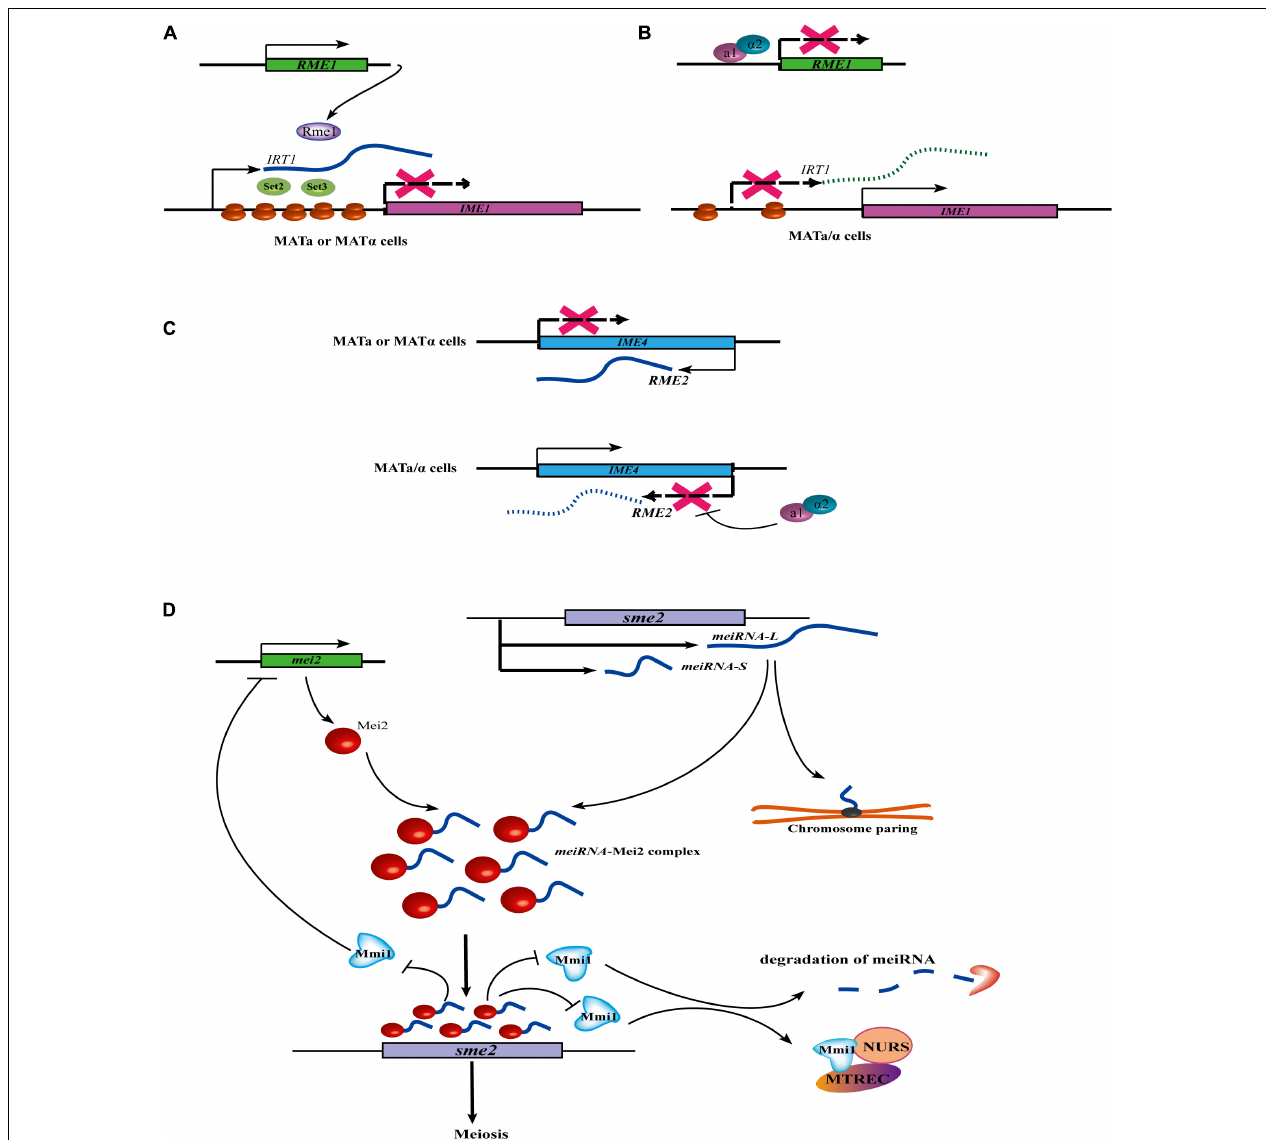
FIGURE 1 | Cell cycle or meiosis control of lncRNA in fungi. (A) In MAT a or MAT α haploid cells, the expression of IRT1 is induced by a transcription activator Rme1. Then transcribed IRT1 can recruit the histone methyltransferase Set2 and the histone deacetylase Set3 at the IME1 promoter, finally leading to the inhibit of IME1 expression. (B) In the homozygous MAT a/ α diploid cells, the a1/ α 2 heterodimer can inhibit the expression of REM1 , so IRT1 can’t be expressed without the induction of Rme1. IME1 can successfully transcript without the repression of IRT1 . (C) In MATa or MAT α haploid cells, lncRNA REM2 inhibits transcription elongation of IME4 to prevent germ cell differentiation. However, in MATa/ α diploid cells, the a1/ α 2 heterodimer represses the transcription of REM2 by binding at a conserved site located downstream of the IME4 , thus allowing for induction of IME4. (D) meiRNA regulates the expression of meiotic gene and chromosome pairing. In meiotic cells, two isoforms of the meiRNA (i.e., meiRNA-S and meiRNA-L ) are transcribed and form a meiRNA- Mei2 complex by interacting with RNA-binding protein Mei2. The Mei2-meiRNA complex blocks the RNA-binding protein Mmi1, thus allowing the sme2 to be translated, thus initiating meiosis. During meiotic prophase in S. pombe , the ends of each chromosome are tied up to the spindle pole body. At the sme2 loci on chromosome II, the formation of a robustly chromosome pairing is dependent on meiRNA . Interestingly, Mmi1 also inhibits Mei2 by forming a double negative feedback loop. In addition, Mmi1 can interact with a nuclear complex called Meiotic gene silencing complex MTREC/NURS MTREC (MTl1-REd1 Core) or NURS (NUclear RNA Silencing) in meiotic transcript elimination.